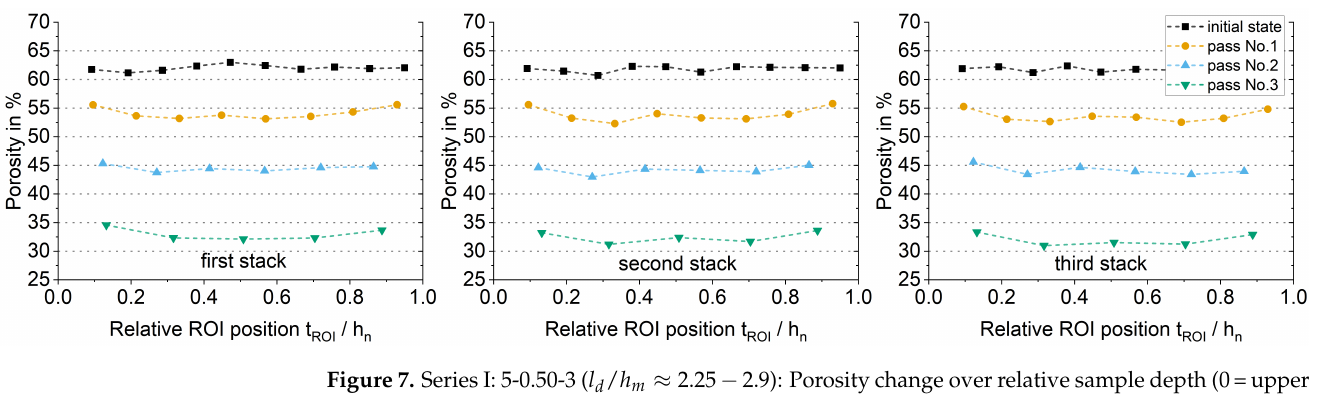
Figure 6. Series I: 5-0.50-1 ( l d / h m ≈ 4.2): Porosity change over relative sample depth (0=upper surface; 0.5= mid-section of sample; 1 =lower surface) due to rolling for first, second and third stack.